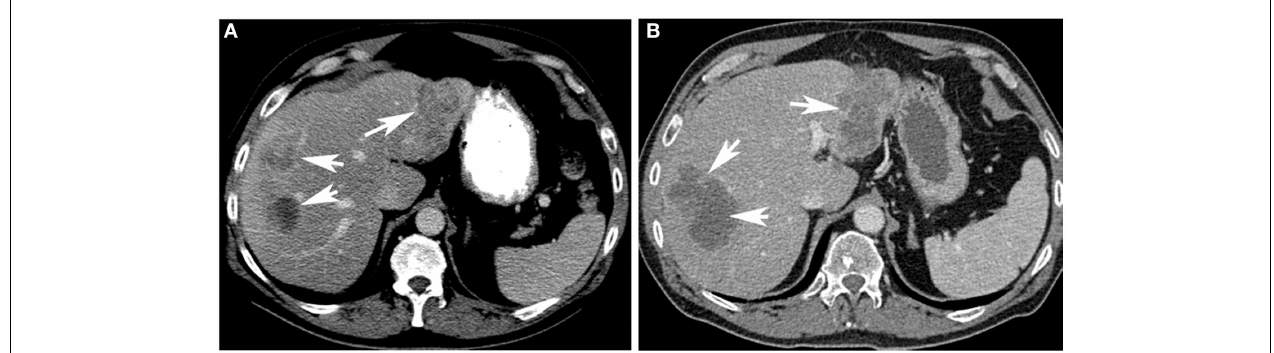
afterY-90 therapy shows very low attenuation of the lesions (arrows). Even though the lesions size has not significantly changed, the development of very low attenuation on post-treatment scan suggests response toY-90